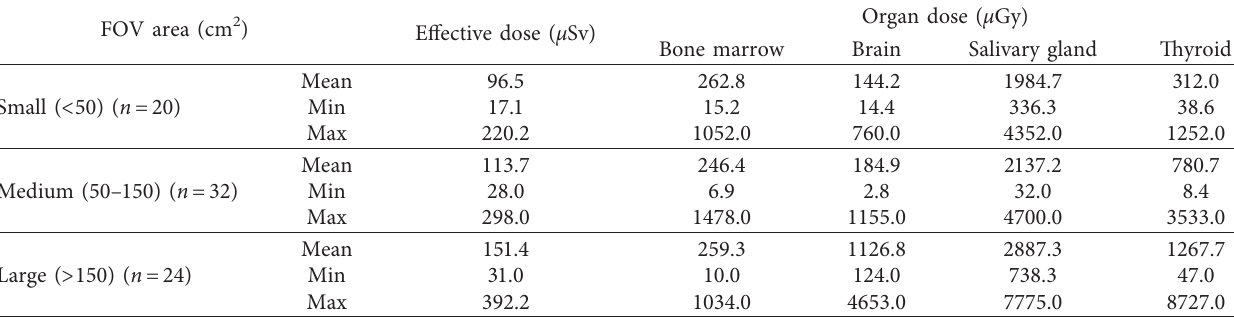
Table 7: Minimum, mean, and maximum values of effective and organ (bone marrow, brain, salivary gland, and thyroid) doses from cone- beam computed tomography procedures by field-of-view area (FOV width × height, cm 2 ) reported in the selected publications.